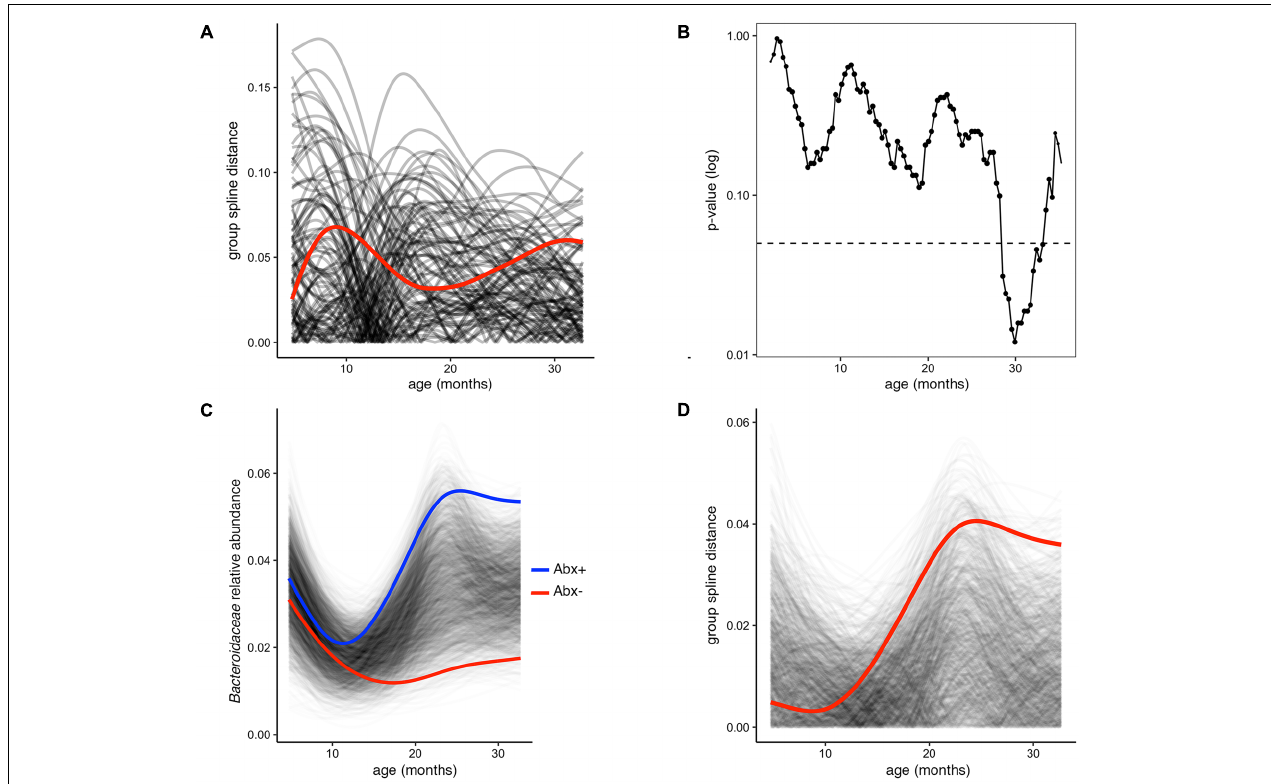
FIGURE 2 | Permuted spline tests for statistical significance in longitudinal microbiome data. (A) The permuspliner output plot shows that the difference between Bacteroidaceae abundance between antibiotic exposed and non-exposed infants (distance between group splines shown as red line) is not significantly greater than 95% of the permuted values shown in translucent black. (B) The plot output of the sliding spliner function shows the p -value at each specified interval (shown with default 100 intervals) derived from the distribution of points from individuals’ smoothed splines. Dotted line indicates p = 0.05. The number of infants with data at a given interval is used to scale the data point size, as some entered and exited the study later or earlier, respectively. (C) Porphyromonadaceae abundance over time distinguishes antibiotic exposed (group spline in blue) and non-exposed infants (group spline in red; 999 permutations, p = 0.053). (D) Group distance plot, as in (A) , for the Porphyromonadaceae comparison, showing that permuted splines support a trend toward a greater true statistical difference after 12 months of life.